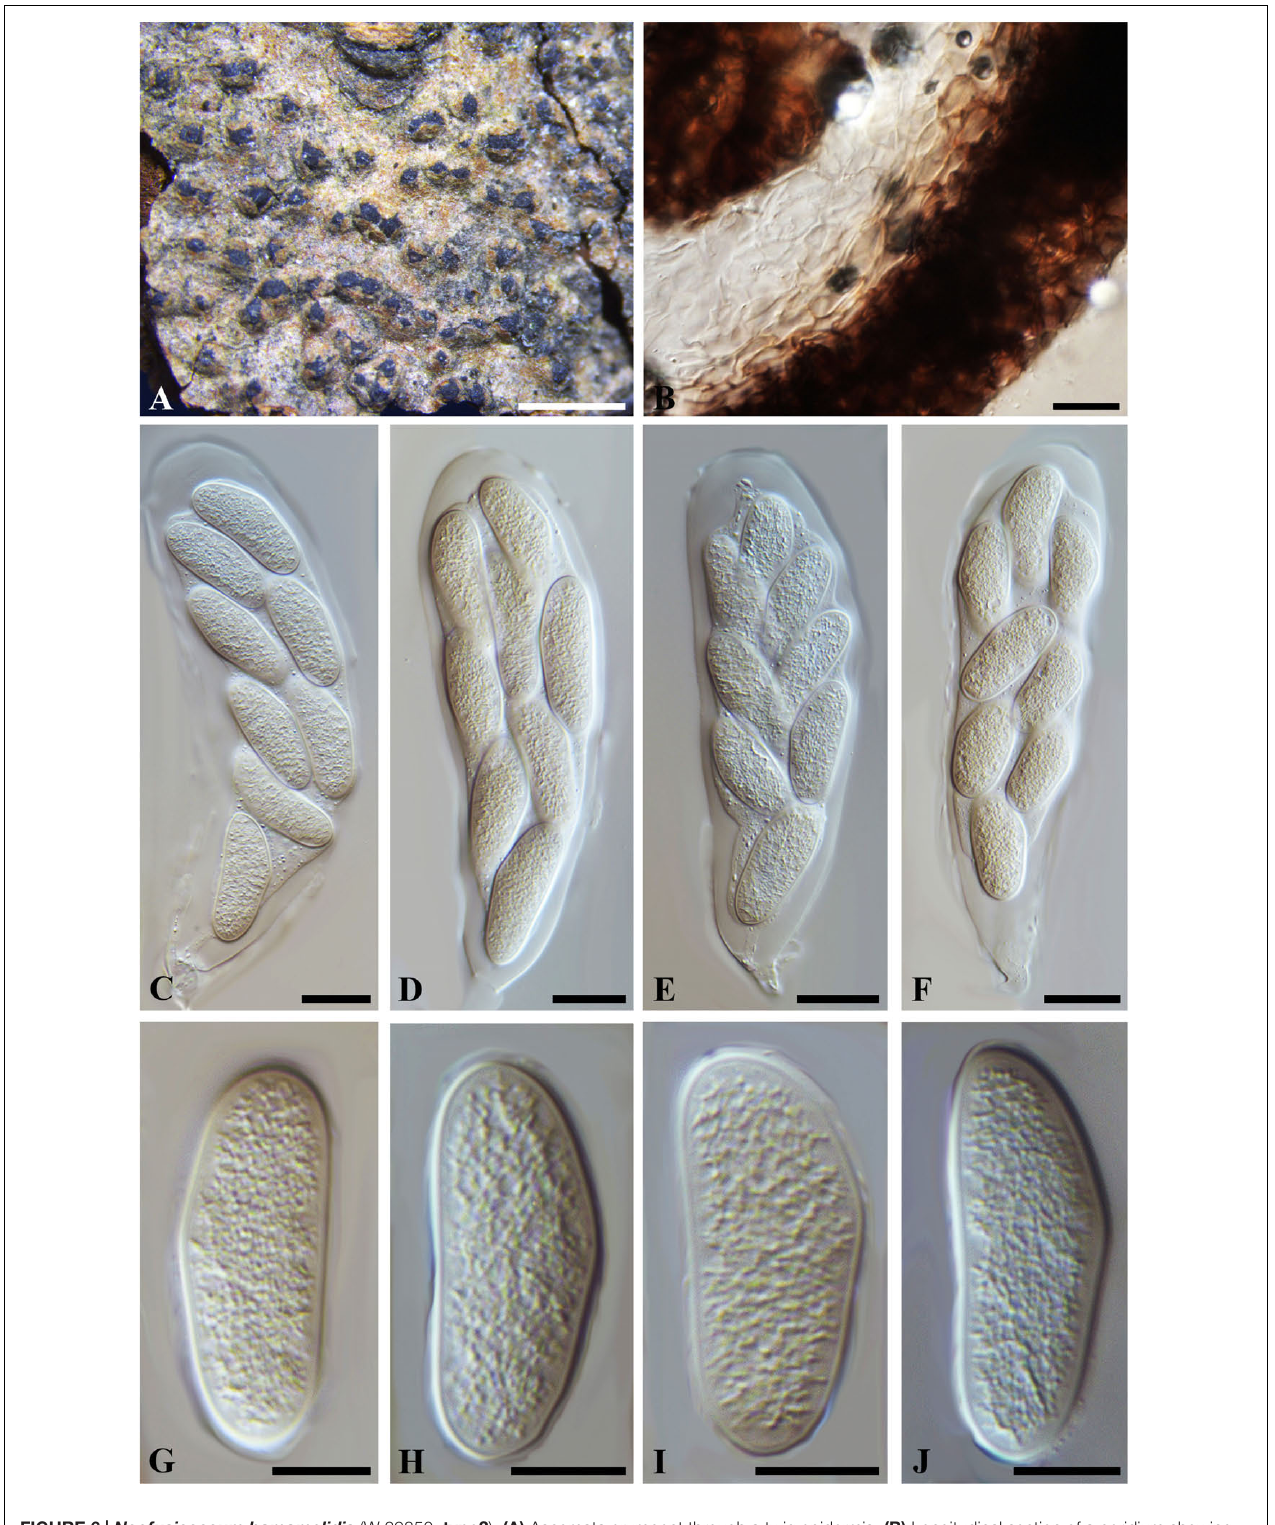
FIGURE 6 | Neofusicoccum hamamelidis (W 29850, type? ). (A) Ascomata erumpent through a twig epidermis. (B) Longitudinal section of a peridium showing the cells of textura angularis . (C-F) Broadly clavate, 8-spored asci with ascospores inside. (G–J) . Hyaline, aseptate ascospores. Scale bars: (A) = 1 mm, (B-F) = 20 µ m, (G-J) = 10 µ